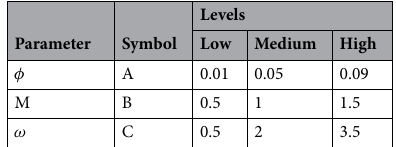
Table 4. Experimental parameters and their levels.